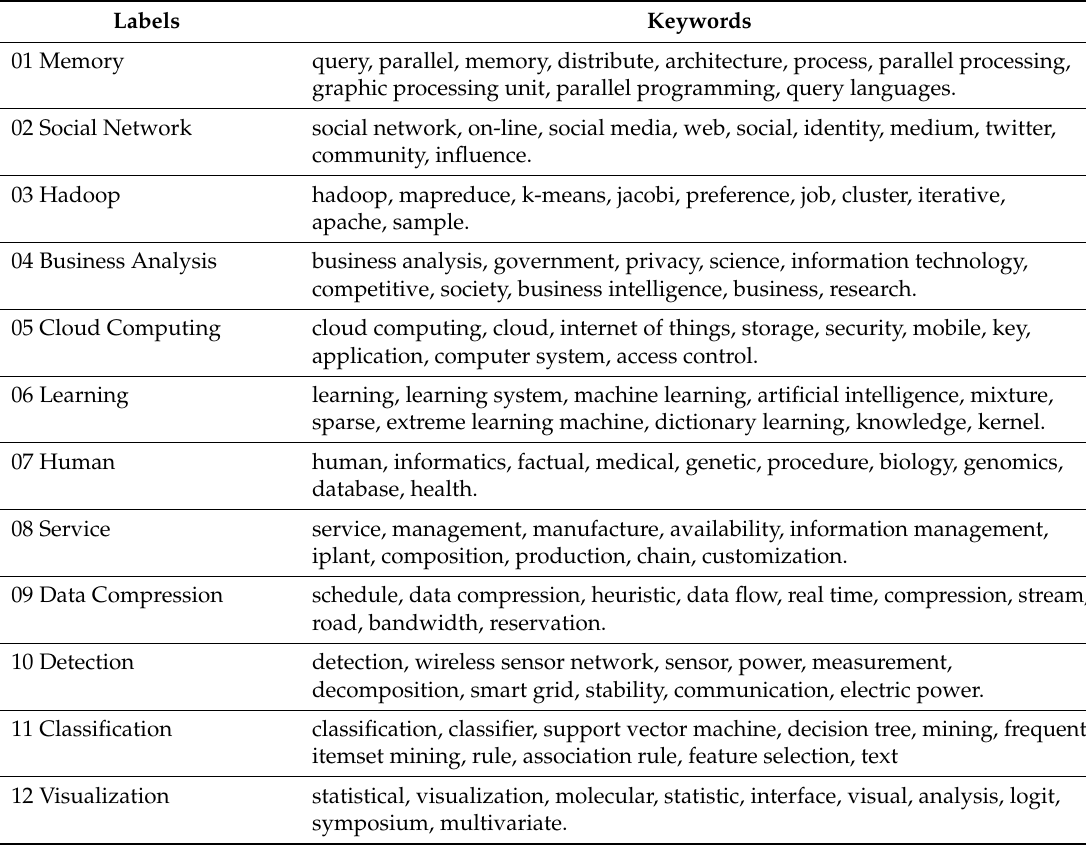
Table A2. Top 10 characteristic keywords in each cluster for the time period 2009–2015.